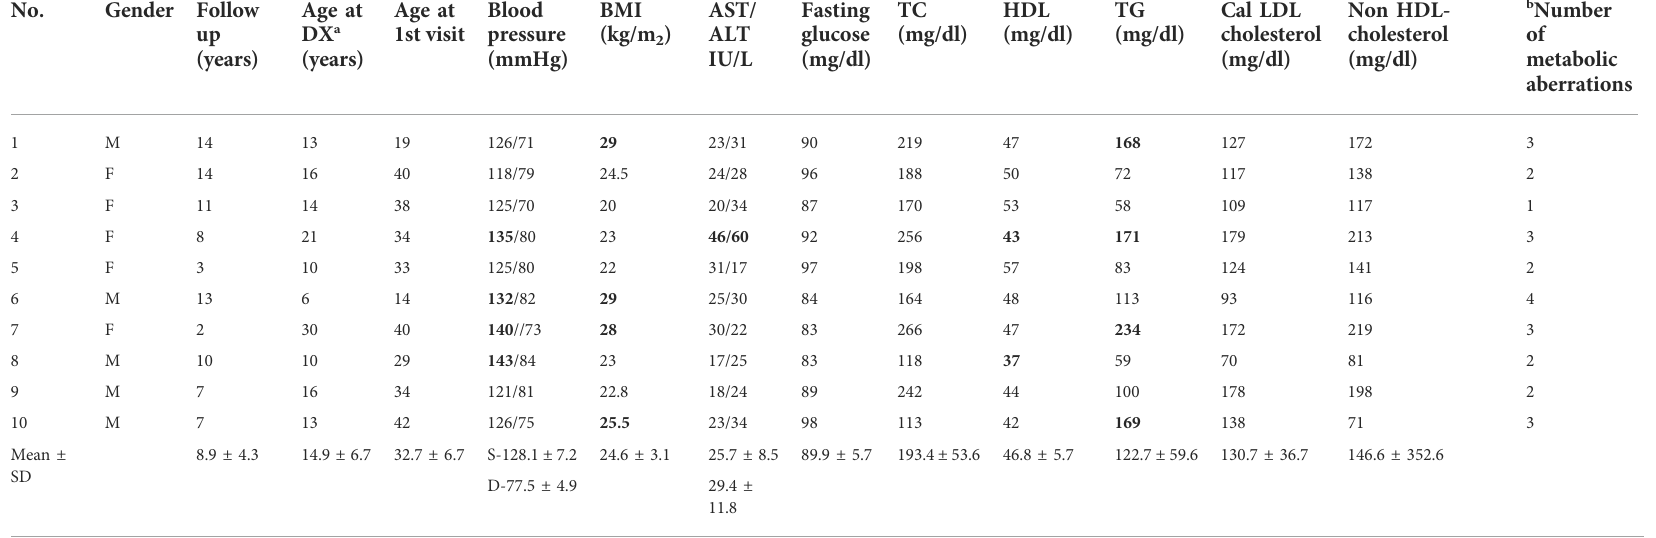
TABLE 1 Baseline Biochemical and clinical characteristics of CTX patients (Features of the metabolic syndrome in bold).